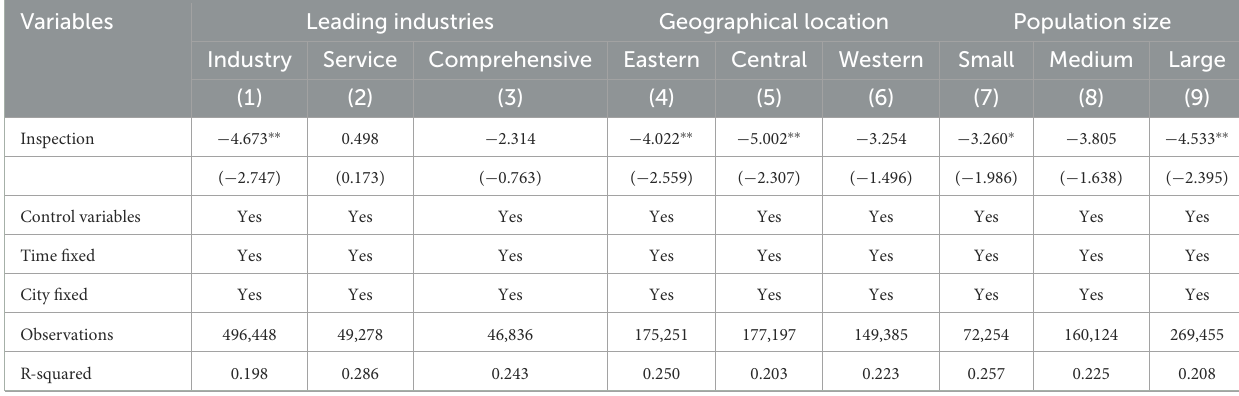
TABLE 8 Heterogeneous test.